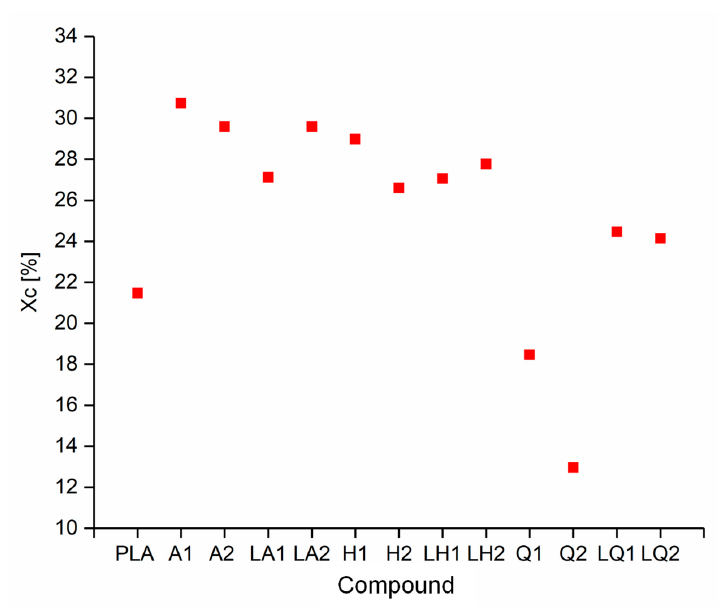
Figure 7. Crystallinity (X c ) of PLA and the PLA / dye compounds.